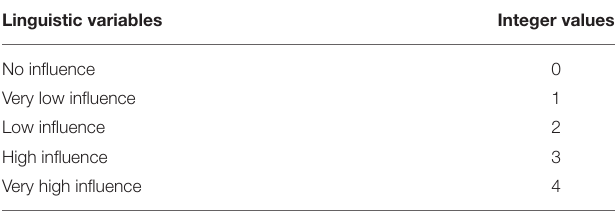
TABLE 2 | Conversion relationship between linguistic variables and integer values. Linguistic variables Integer